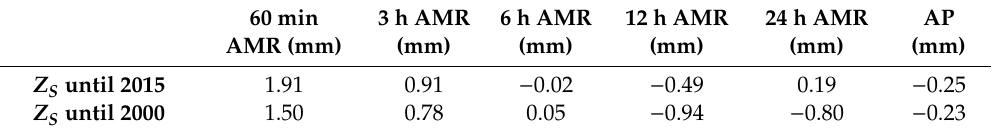
Table 1. Viterbo rain gauge: results of Mann–Kendall (MK) test for the investigated sample time series.